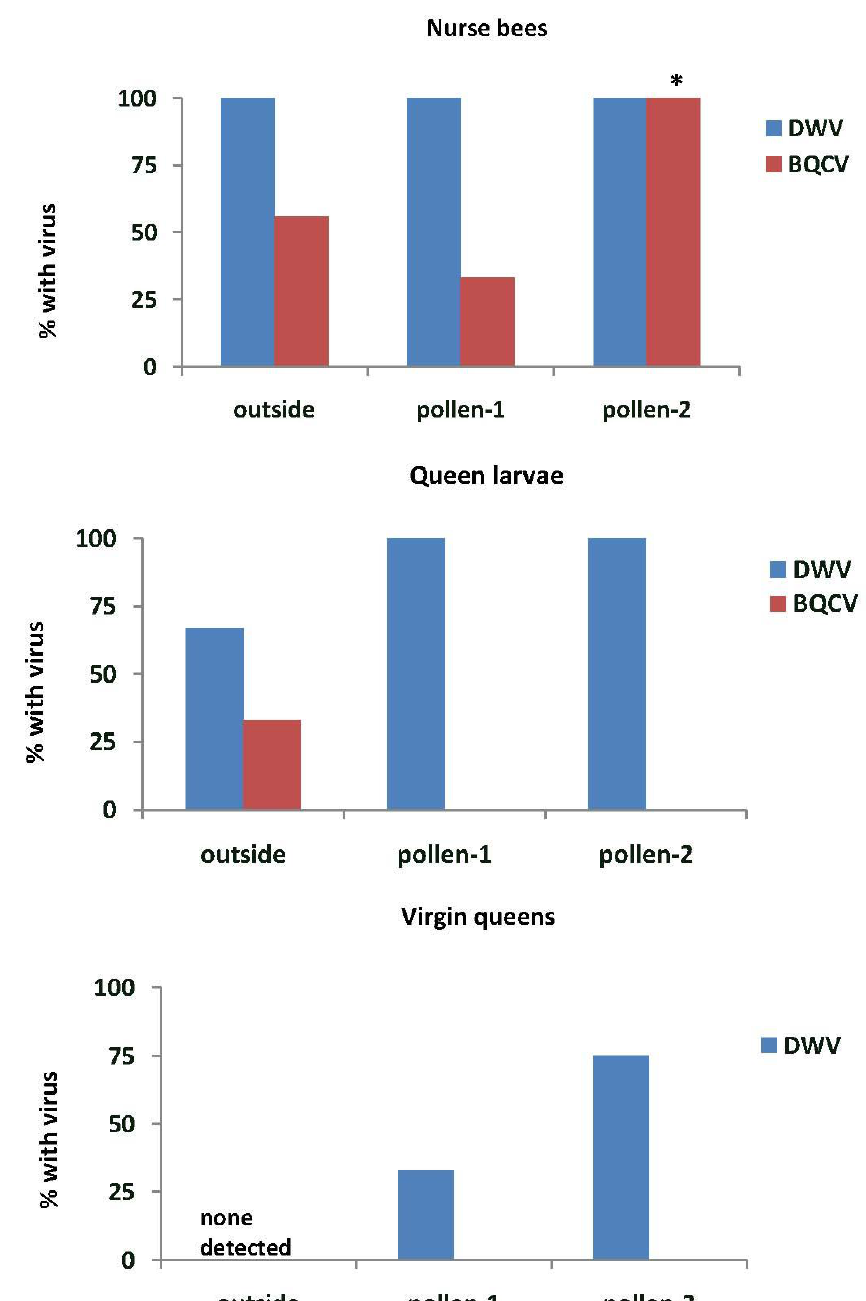
Figure 5. Nurse bees, queen larvae and virgin queens with deformed wing virus (DWV) and Black queen cell virus (BQCV). Samples were taken from open foraging colonies in an apiary (outside) or foraging in an enclosed flight are (EFA) and fed pollen with chlorpyrifos alone (pollen-1) or with added Pristine ® fungicide (pollen-2). Percentages of nurse bees with virus were based on samples of 9 nurse bees from outside colonies, 12 from colonies fed pollen-1 and 15 from those fed pollen-2. Nurse bees were sampled from those tending the queen cells. The percentages of queen larvae and virgin queens were analyzed based on three samples from colonies in each treatment group. Percentages with an asterisk are significantly different at p < 0.05 as determined by a Chi-square goodness of fit